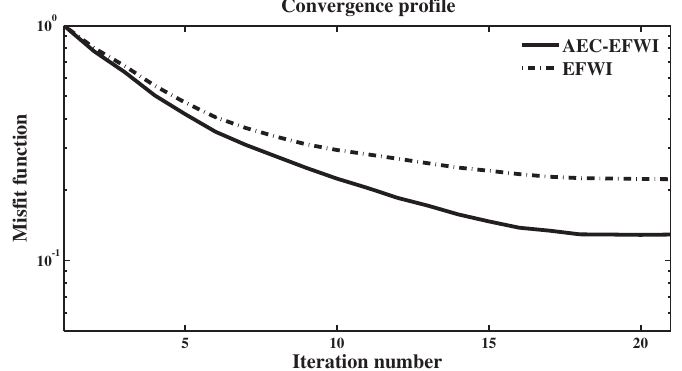
Figure 17. Convergence profiles of the AEC-EFWI (solid) and EFWI (dashed)